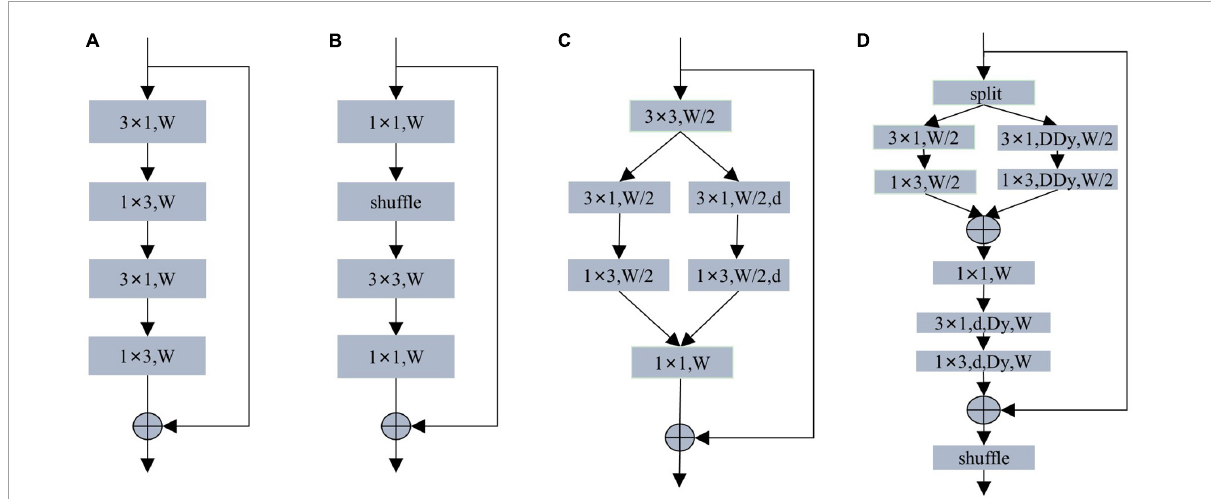
FIGURE4 (A) Non-bottleneck-1D module. (B) ShuffleNet module. (C) DAB module. (D) Our MS-DAB module. W denotes the number of input channels. d denotes dilated convolution. DDy denotes depth-separable dynamic convolution. Dy denotes dilated dynamic convolution. For brevity, the batch normalization and activation functions are not